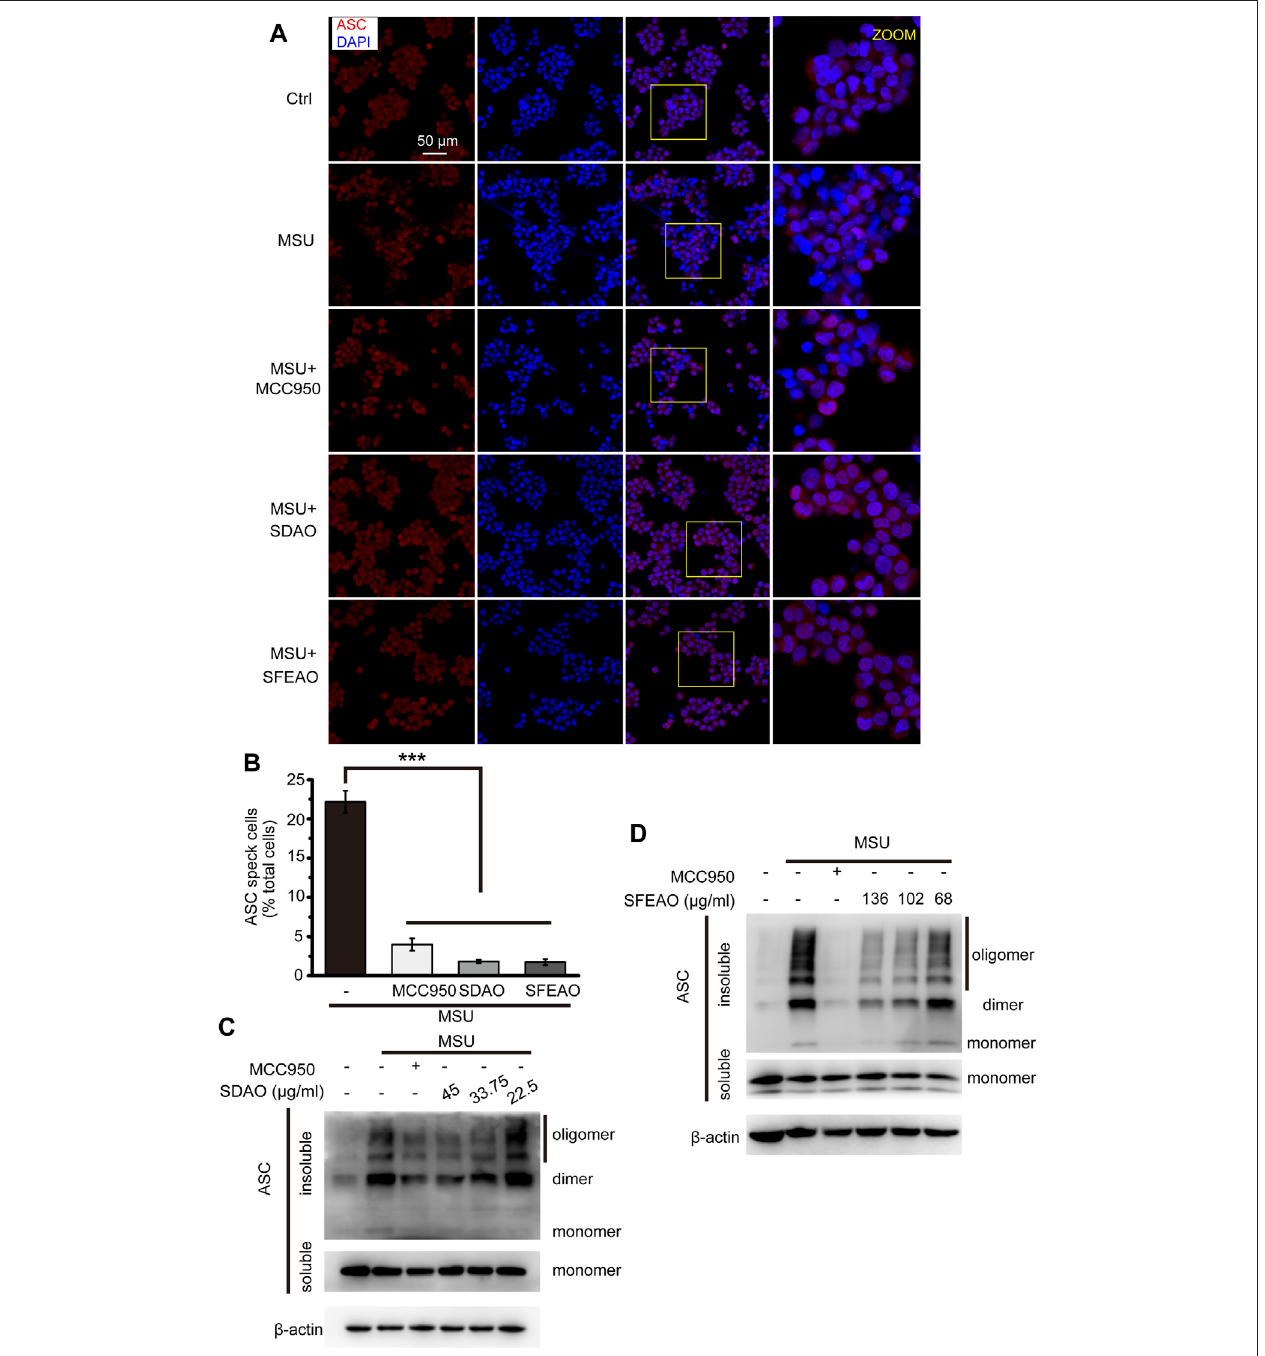
FIGURE 5 | EOAA inhibits the formation of ASC oligomers induced by MSU. PMA-primed THP-1 cells were treated with or without MCC950 (20 μ M) or different concentrations of SDAO or SFEAO upon stimulation with MSU (500 μ g/ml) for 6 h. (A) Cells stained with anti-ASC antibody for ASC specks (red) and DAPI for nuclei (blue). The concentrations of SDAO and SFEAO were 45 and 136 μ g/ml, respectively. (B) The percentage of cells with ASC specks among all cells is presented. (C , D) ASC oligomers were extracted from the Triton X-100 insoluble part of the cell extract by DSS crosslinking and measured by immunoblotting. ASC speck was quanti fi ed bythe cells with ASC specks relative tothe total cells from three individual fi elds in each experiment. Data were from three independentexperiments ( B ; mean andSEMof n (cid:2) 3)orarerepresentativeofatleastthreeindependentexperiments (A , C , D) .Arcsine-squareroottransformationofthepercentdatawasusedforstatistical analysis. Statistics were analyzed using one-way ANOVA by Bonferroni post hoc test, * p < 0.05, ** p < 0.01, *** p < 0.001.